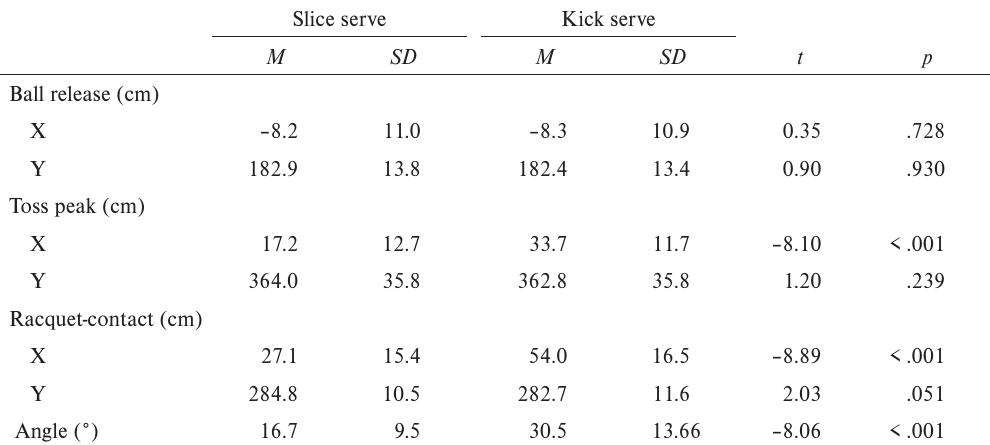
Ball toss kinematics of slice serve and kick serve – ad